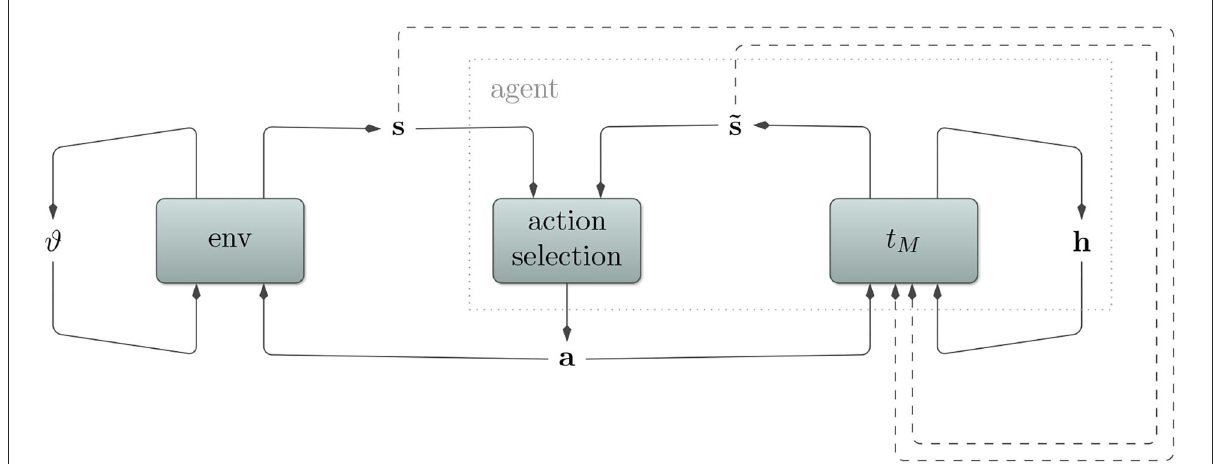
FIGURE1 Depiction of a (partially observable) Markov decision process. An agent interacts with its environment by sending actions a and receiving consequent sensory states s . Partial observability here implies that the sensory state s does not encode the whole environmental state ϑ . Rather, certain aspects remain hidden for the agent and must be inferred from the sensory state. To deal with this, our agent utilizes a transition model s , which aid the action selection algorithm to produce appropriate actions. In t M with its own internal hidden state h . It predicts sensory states ˜ order to stay in tune with the environment and to predict multiple time steps into the future, the transition model also receives observed and predicted sensory states (dashed